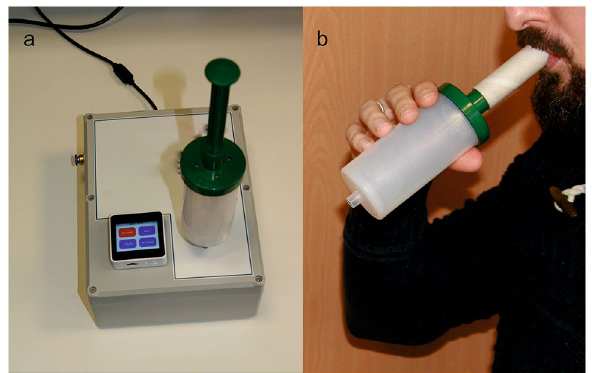
Figure 1. ( a ) Developed electronic nose analyzing the sample of exhaled breath by using the end-tidal part the final wave, and ( b ) illustration of collecting the breath sample with the